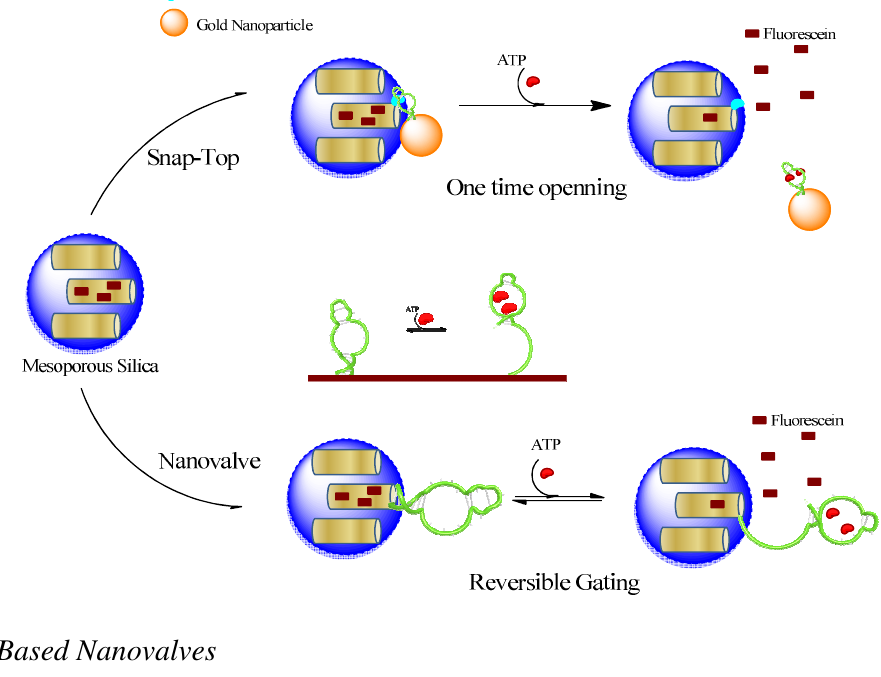
Figure 4. Schematic illustration of aptamer-target responsive controlled drug delivery systems. Two approaches has been adapted by using aptamers as molecular gates; ( a ) Snap-top gating; and ( b )